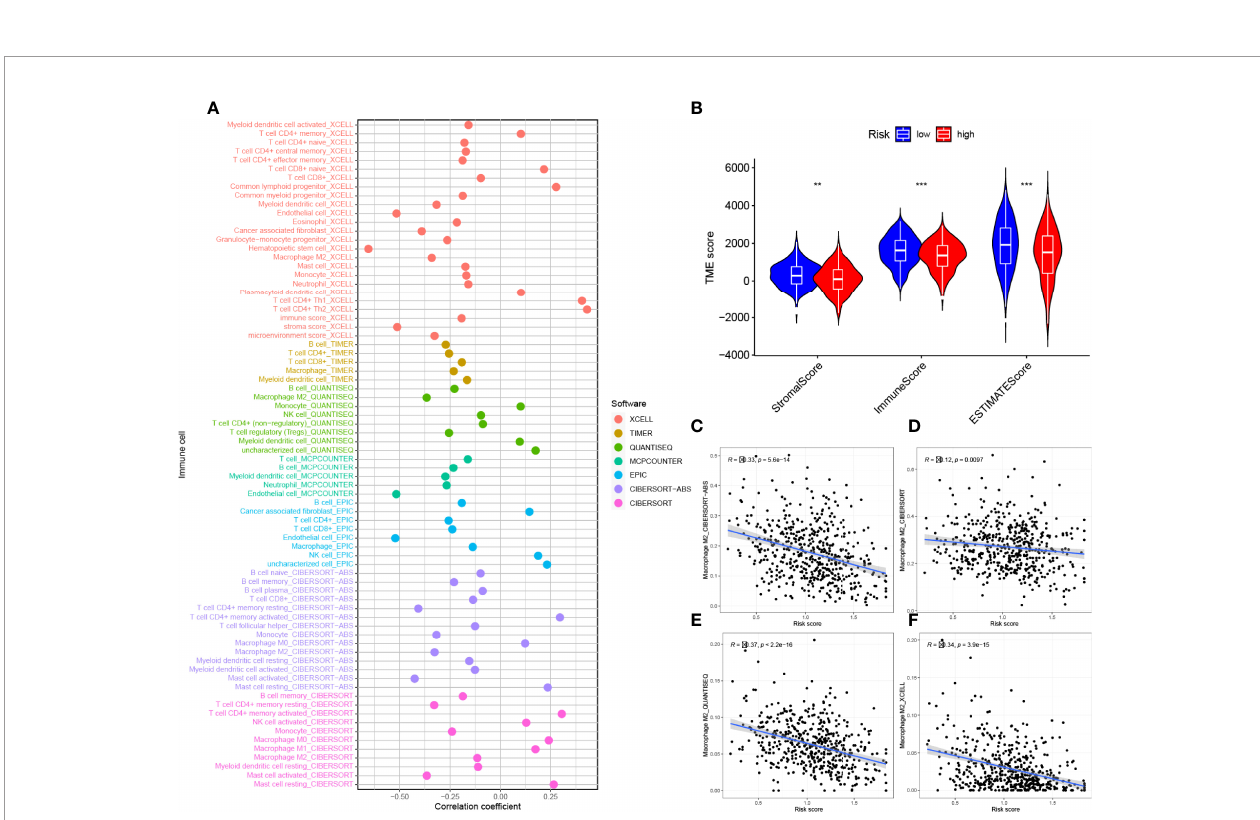
FIGURE 9 | Estimated abundance of tumor-in fi ltrating cells. Patients in the (A) high-risk group had a stronger correlation with tumor-in fi ltrating immune cells, as shown by the Spearman correlation analysis. (B) Association between prognostic risk signatures and central immune checkpoint genes. The asterisks represented the statistical p value (**P < 0.01; ***P < 0.001).The correlations predicted by the four methods CIBERSORT − ABS (C) , CIBERSORT (D) , QUANTISEQ (E) , and XCELL (F) were